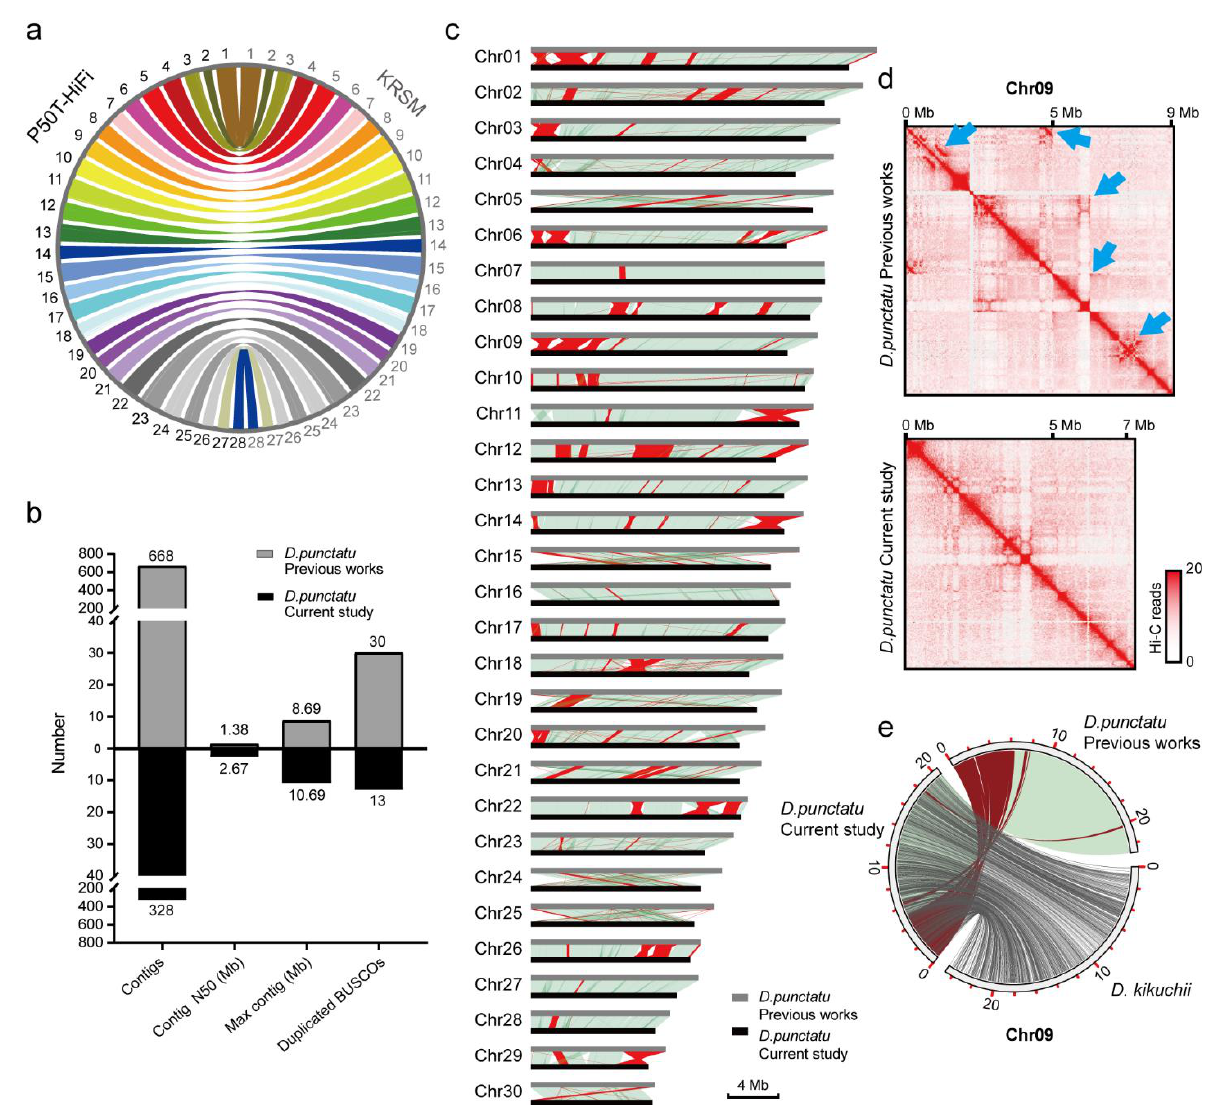
Figure 7. Summary of KRSM and Dendrolimus punctatus (D. punctatus) assemblies. ( a ) The synteny between silkworm P50T-HiFi and KRSM genomes. ( b ) Comparative analysis of the metric values of D. punctatus genome assemblies between the previous studies and this study. Contig numbers (Contigs), N50 of contigs (Contig N50), the maximum length of contigs (Max contig) and duplicated complete BUSCO gene number (Duplicated BUSCOs). ( c ) Collinearity of D. punctatus genome assemblies in previous research and this study. The synteny blocks are shown by light green lines. The inversions are indicated by red lines. ( d ) Hi-C interaction map of D. punctatus chromosome 9. The assembly errors in previous research were marked by blue arrows. ( e ) Collinearity circle plots. The synteny blocks are shown by light blue and gray lines. The inversions are indicated by red lines. It showed that the genome of D. punctatus (in this study) shared good collinearity with Dendrolimus kikuchii (D. kikuchii) , and confirmed the assembly errors in previous studies.